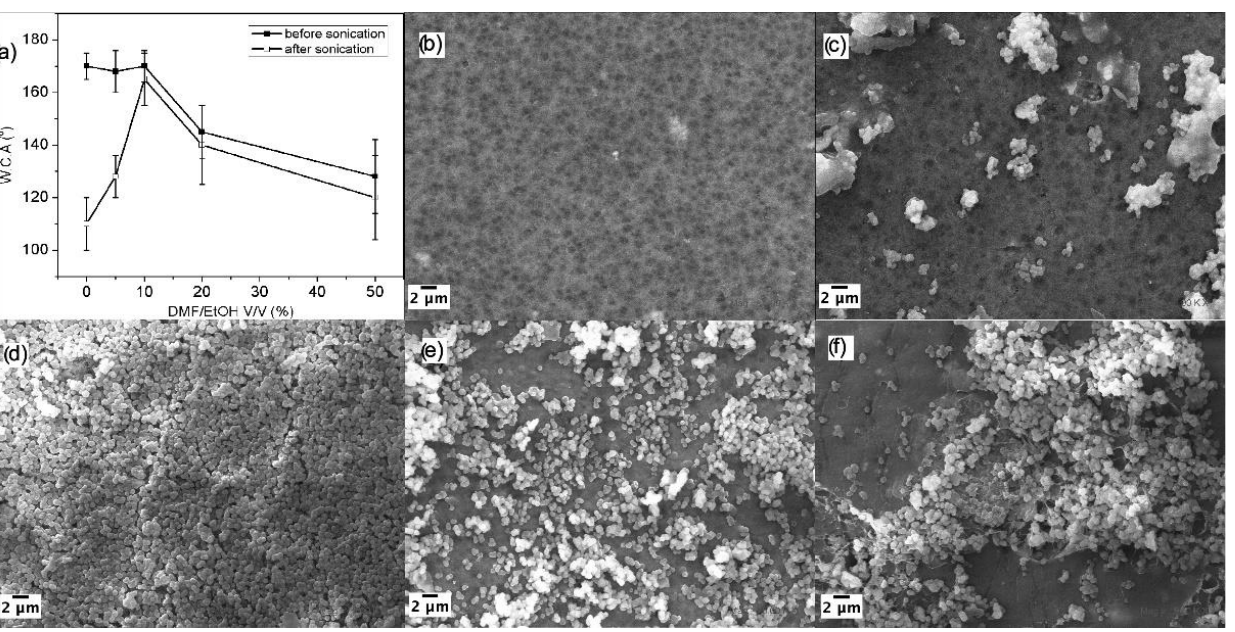
Figure 2. ( a ) Influence of volume ratio of DMF/EtOH (v/v%) on the WCA values of the modified membrane, before (filled square) and after (open square) sonication. SEM micrographs after soni- cation of the membrane surface sprayed with the solution containing DMF at ( b ) 0%, ( c ) 5%, ( d ) 10%, ( e ) 20% and ( f ) 50%v/v.